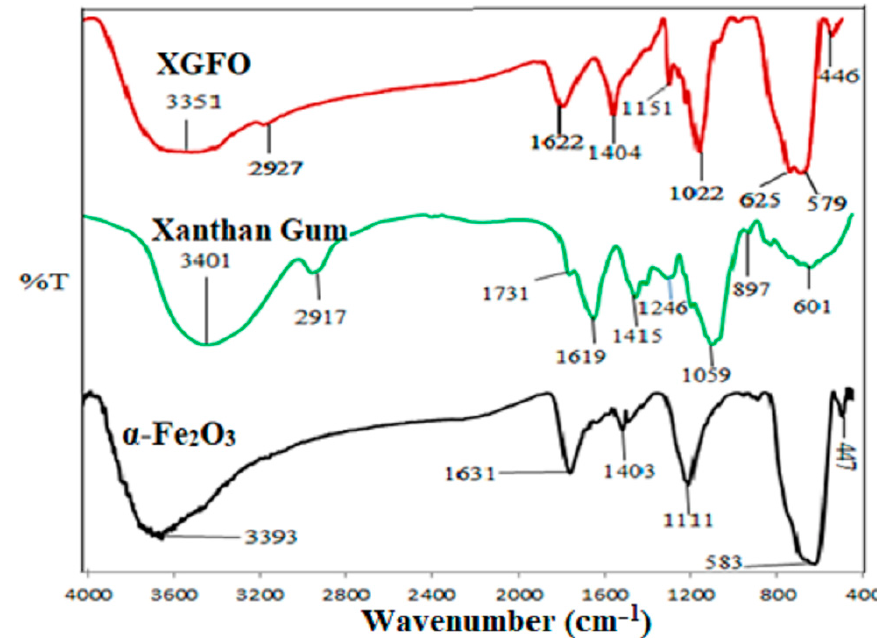
Figure 1. FTIR spectra of α -Fe 2 O 3 (black line), Xanthan Gum (green line), XGFO (red line).